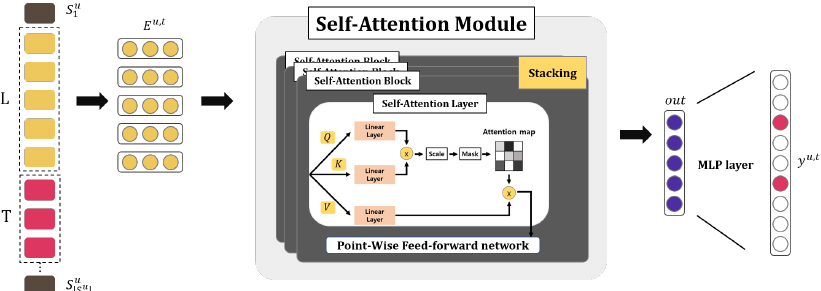
Figure 4. Model architecture of self-attentive sequential recommendation (SASRec) [11].